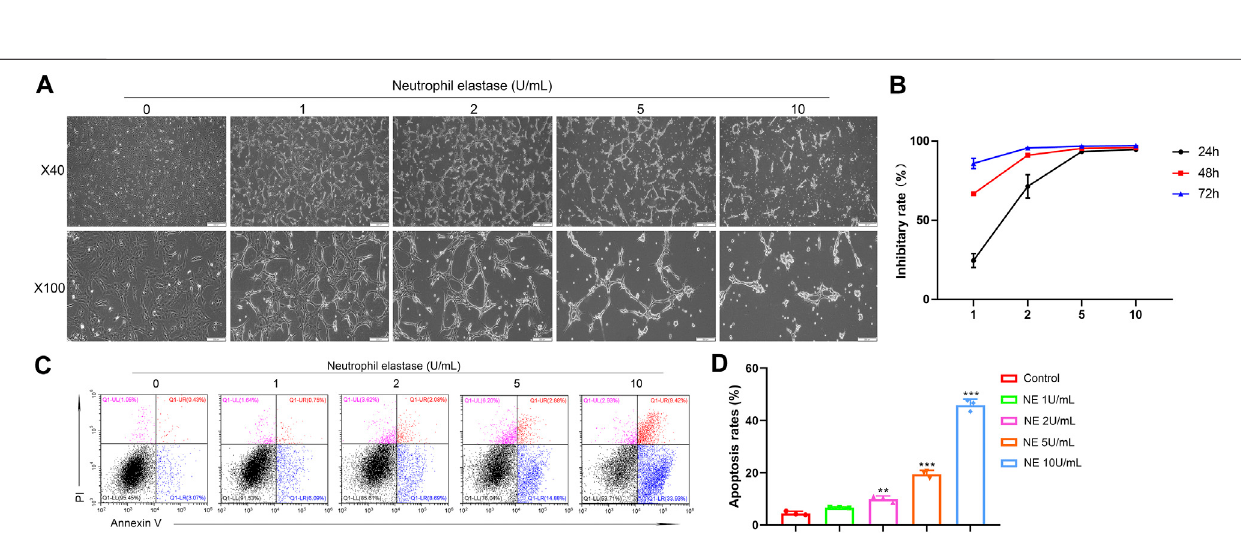
Frontiers in Pharmacology |